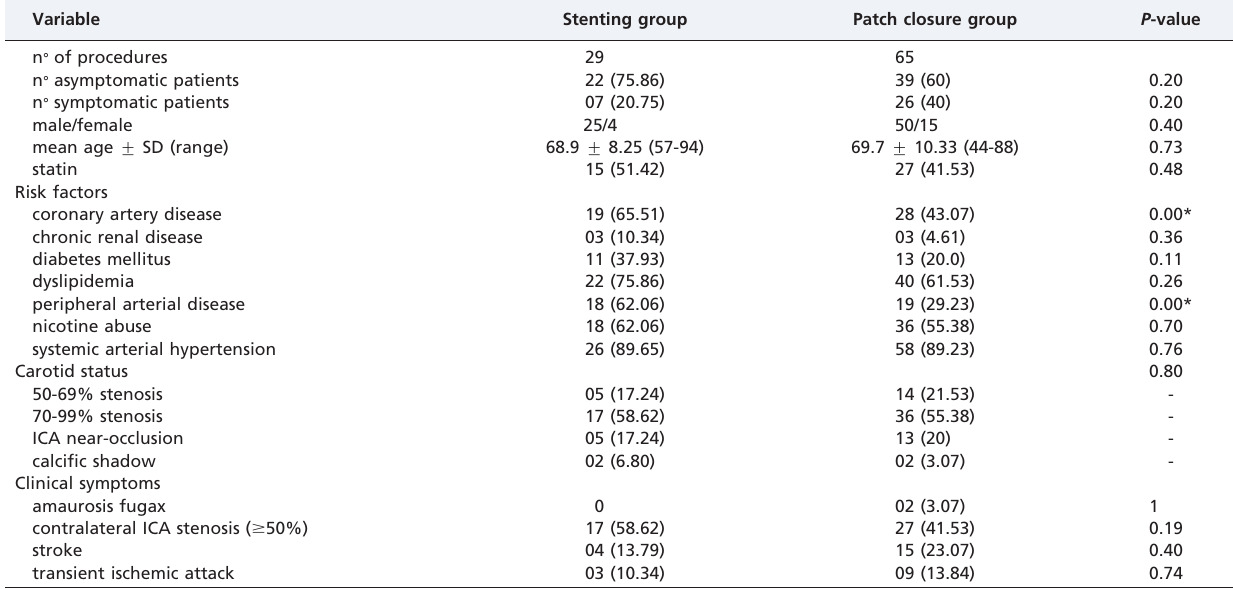
Table 1 – Baseline characteristics of patients according to